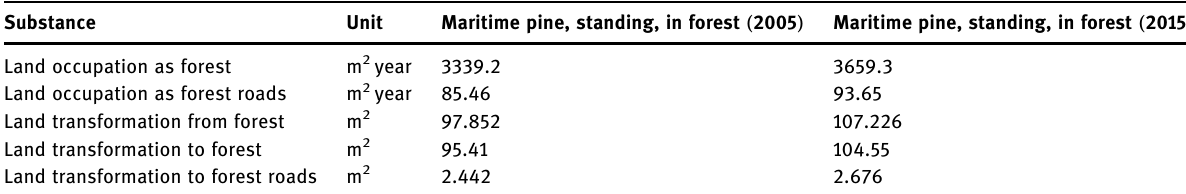
Table 1: Inventory table ( FU = 1 m 3 of maritime pine, standing, in forest )